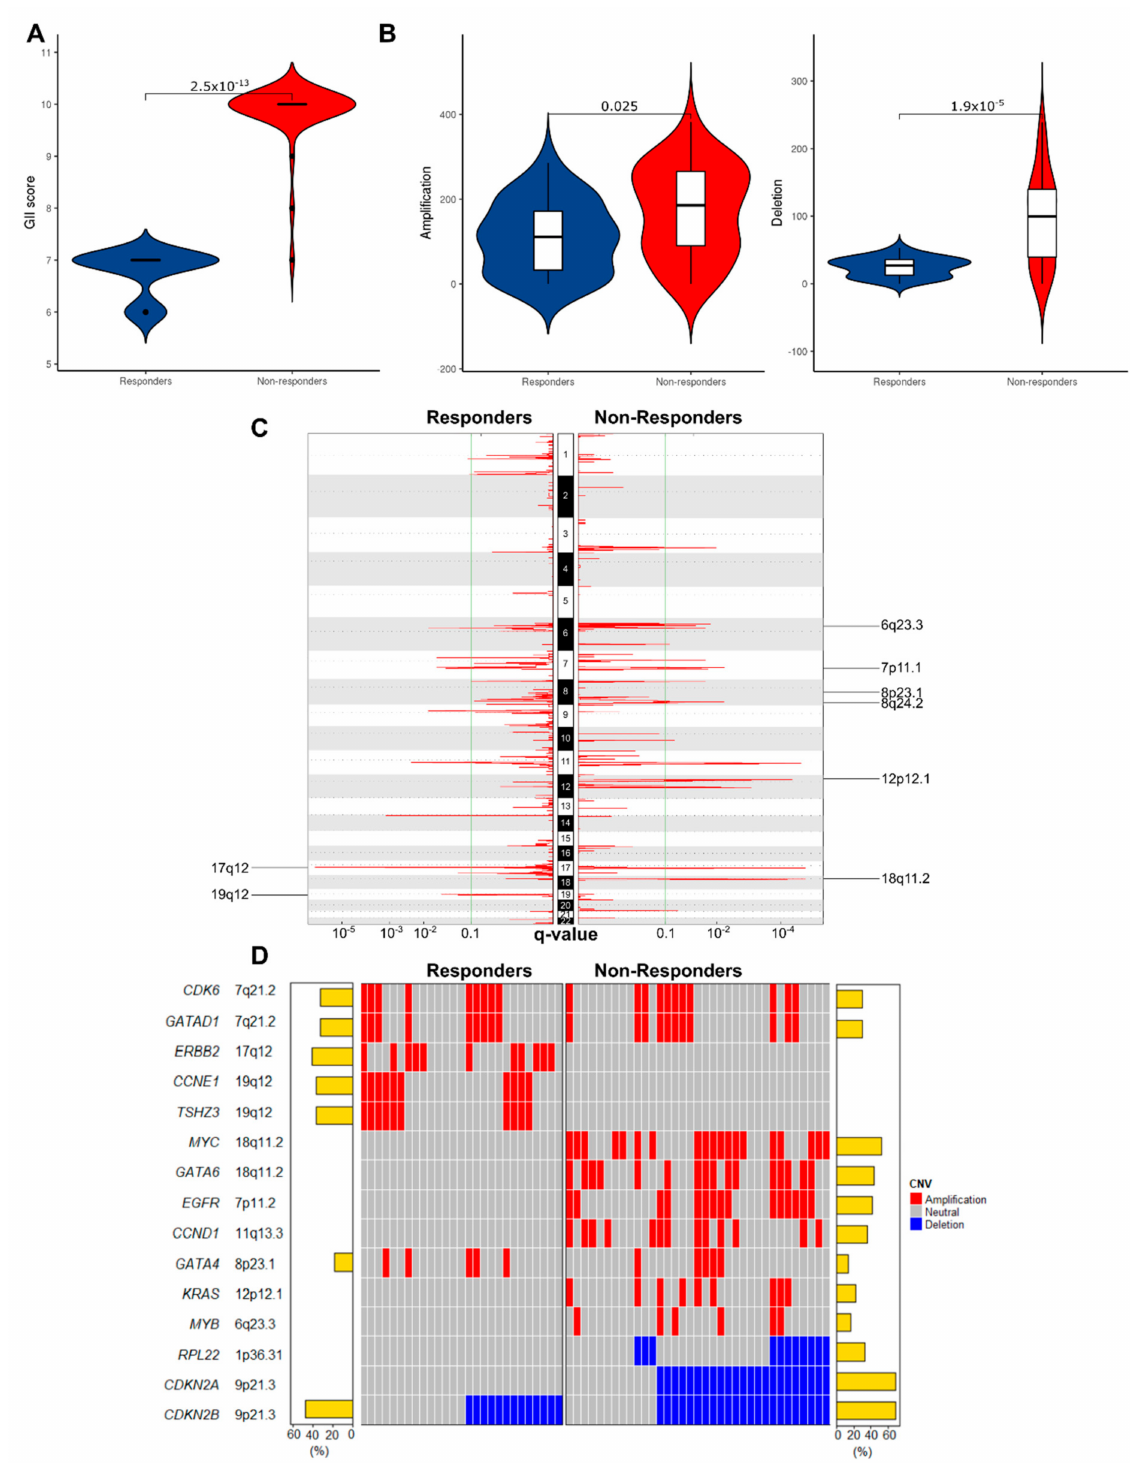
Figure 3. Non-responders have less stable genomes and unique patterns of copy number change in EAC driver genes. ( A ) Proportions of the genome affected by copy-number changes (Genomic Instability Index, GII). Non-responders showed a higher level of genomic instability ( p = 2.5 × 10 − 13 ). ( B ) Violin plots depicting the frequency of all amplifications and deletions in responders and non-responders. ( C ) Amplified peak regions across the genome plotted for responders vs non-responders ( n = 63) using GISTIC2.0 (FDR < 0.1). Amplifications unique to each group are labeled. ( D ) Oncoplot of recurrently amplified/deleted EAC drivers among responders and non-responders identified by GISTIC2.0 (FDR <